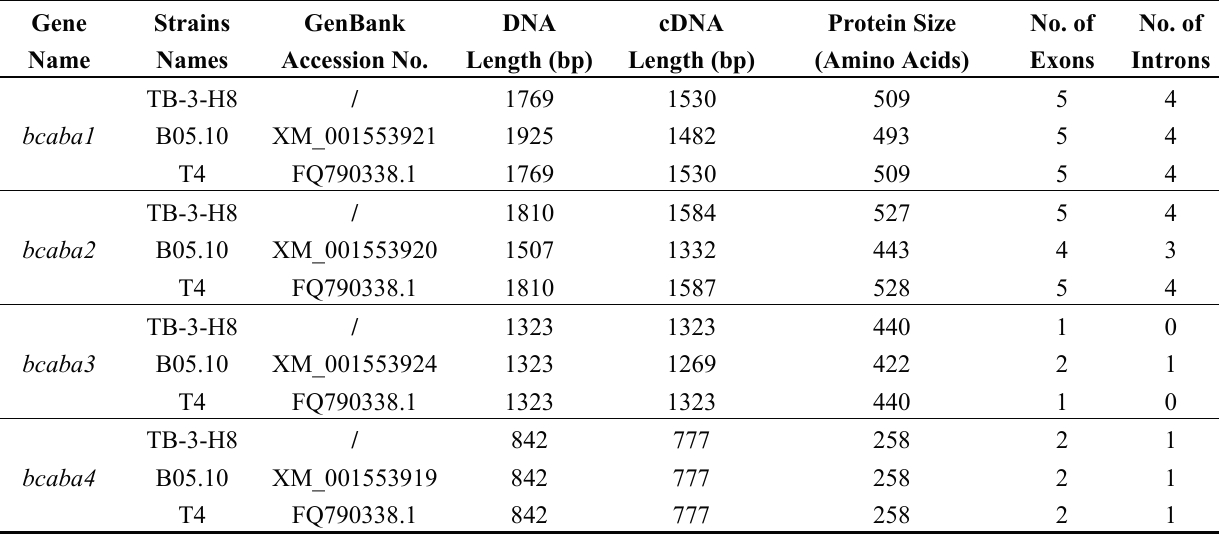
Table 1. bcaba1-4 genes identified in B . cinerea